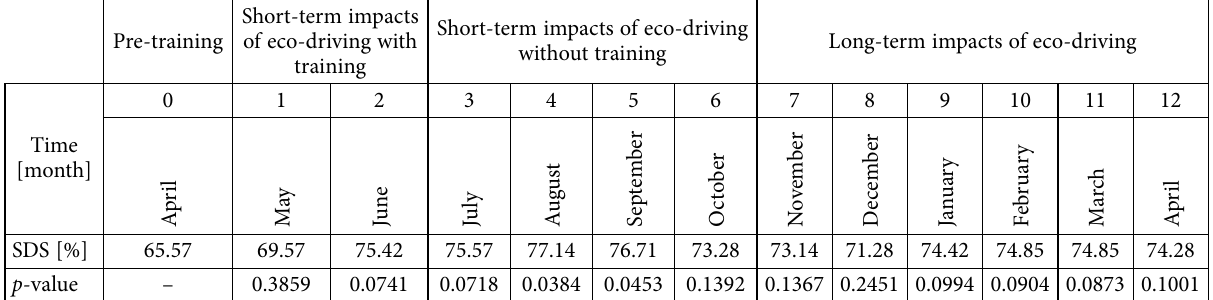
Table 3. p -values from post-hoc Duncan’s test for ANOVA for all average monthly values of the SDS parameter during the observed period Short-term impacts Short-term impacts of eco-driving Long-term impacts of eco-driving Pre-training of eco-driving with without training training